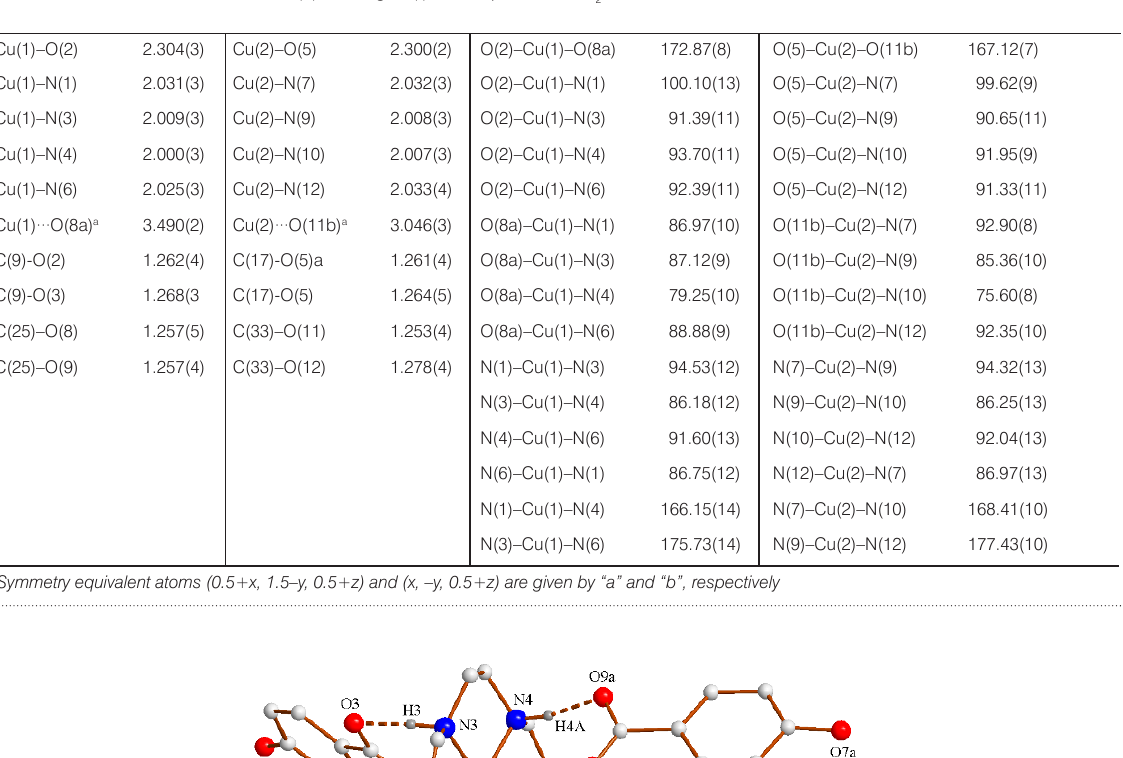
Table 2. Selected bond distances (Å) and angles (°) for compound 3 •11H